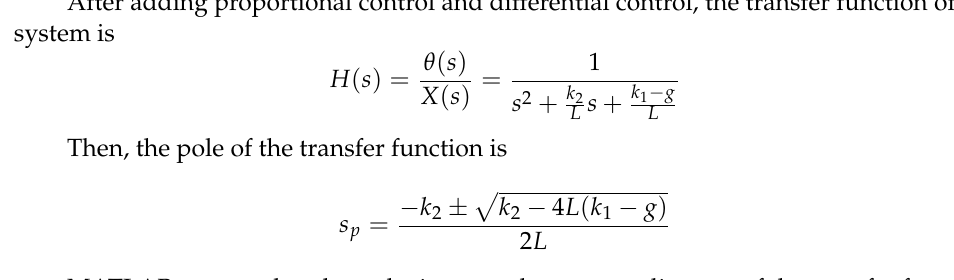
Figure 8. System block diagram of adding negative feedback control.